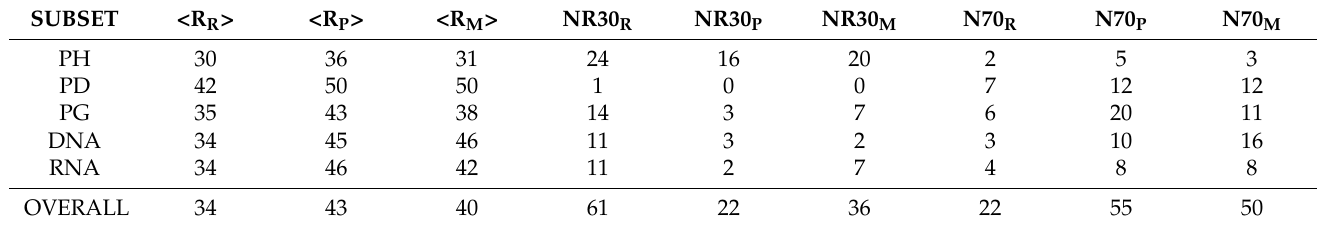
Table 2. Performance comparison of REMO22, PHASER and MOLREP (the subscripts R, P and M represent the three MR programs) The final average R values (in %), denoted by <R R >, <R P > and <R M > respectively, were calculated for each subset of test structures. NR30 R , NR30 P and NR30 M are the number of test structures for which the final R value was ≤ 0.30. N70 R , N70 P , and N70 M are the number of test structures for which the final <| ∆ φ |> value of ≥ 70 ◦